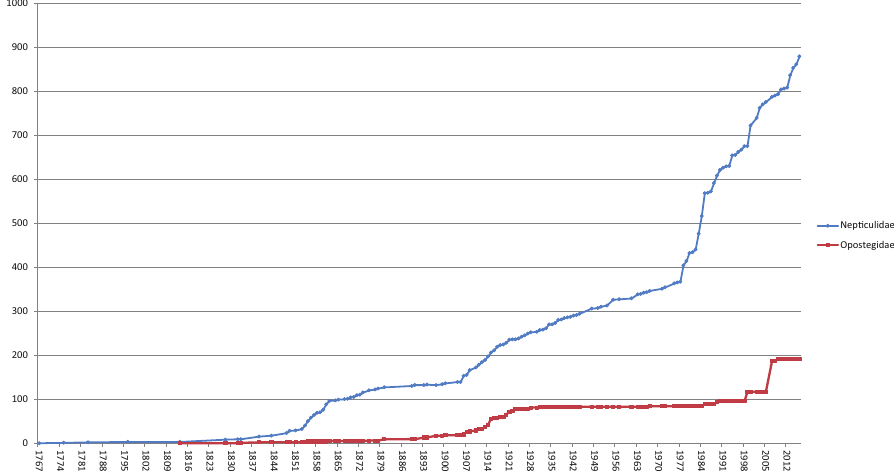
Figure 24B. Cumulative number of valid species of Nepticulidae and Opostegidae described per year. Notice the long period that no Opostegidae were described (1935–1967) and the sudden increase in numbers of Nepticulidae since